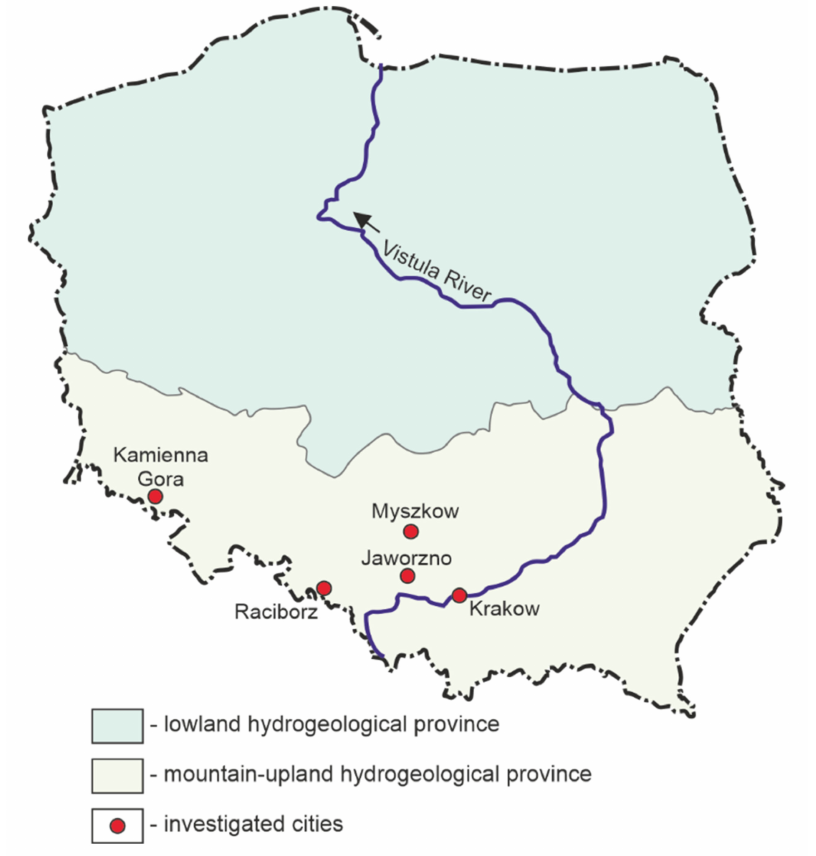
Figure 1. Location of the study